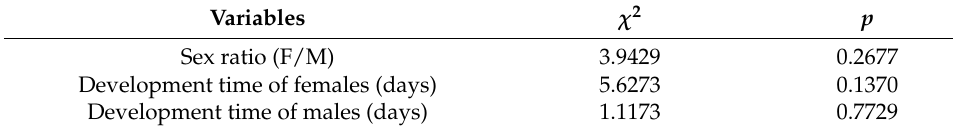
Table 2. Sex ratio and development time of parasitoid wasp tested as variables by applying Kruskal– Wallis test ( χ 2 , df = 3, p ) to differentiate inoculant treatments grouping (N = 9). Control: M − R −